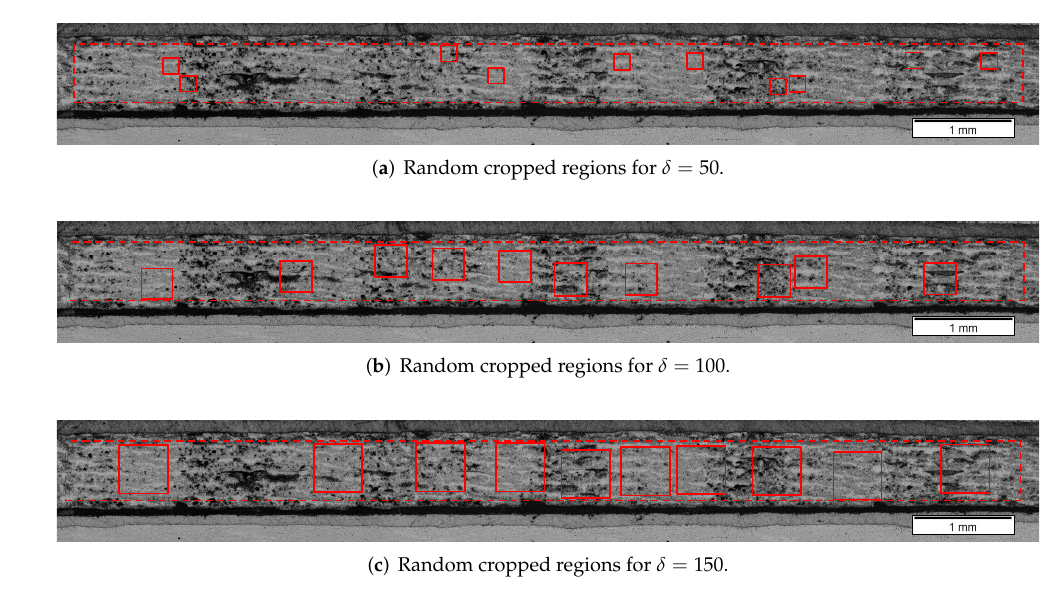
Figure 5. Cross-section micrograph of sample TE-90-4-1 with random cropped regions for δ = 50, δ = 100, and δ = 150, and target fiber volume fraction V ∗